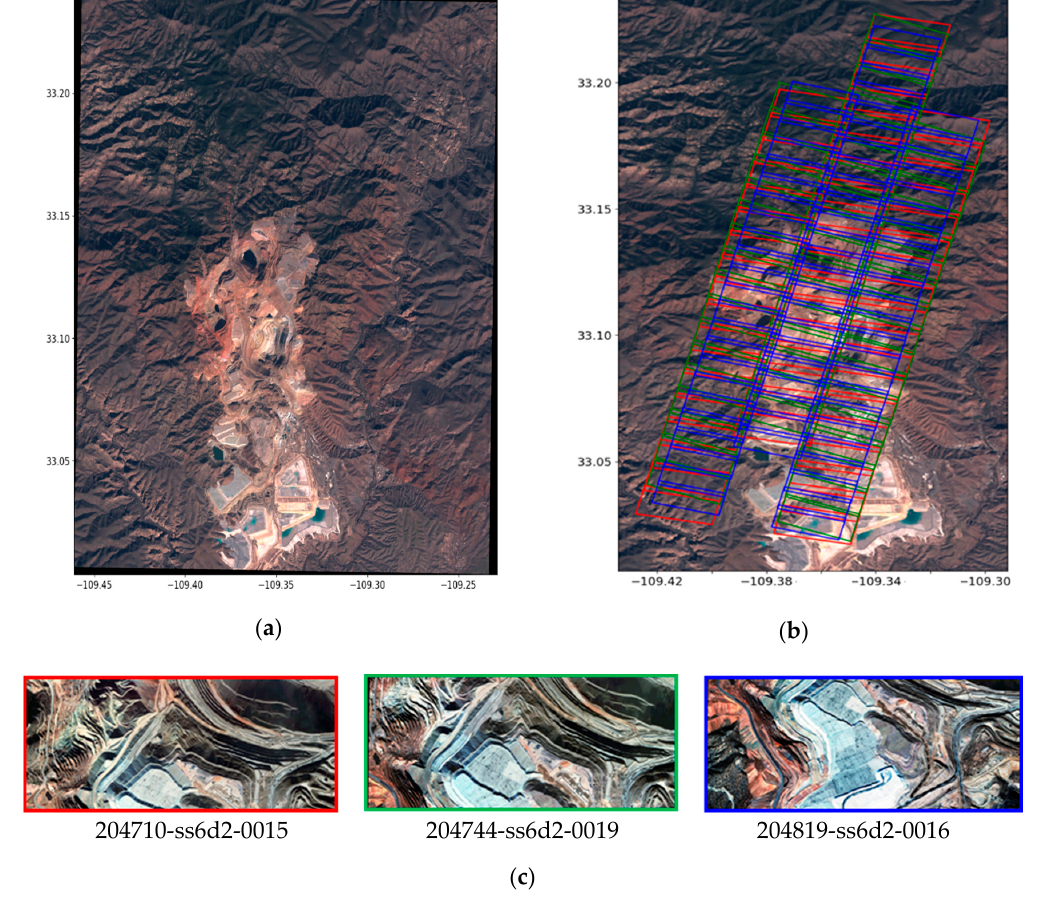
Figure 6. The test site Morenci Mine, AZ, USA. ( a ) Subset of Sentinel-2 true color ortho-image (TCI) over the study area captured on 1 February 2020; ( b ) Outlines of SkySat triplets on a Sentinel-2 ortho-image. Red, Green and Blue bounding boxes delineate the individual scenes of along track forward, nadir and backward views, respectively; ( c ) Tri-stereo RGB SkySat scenes for visual interpretation, from left to right, backward, nadir and forward. Table 1. Acquisition parameters for the SkySat tri-stereo over Morenci Mine study